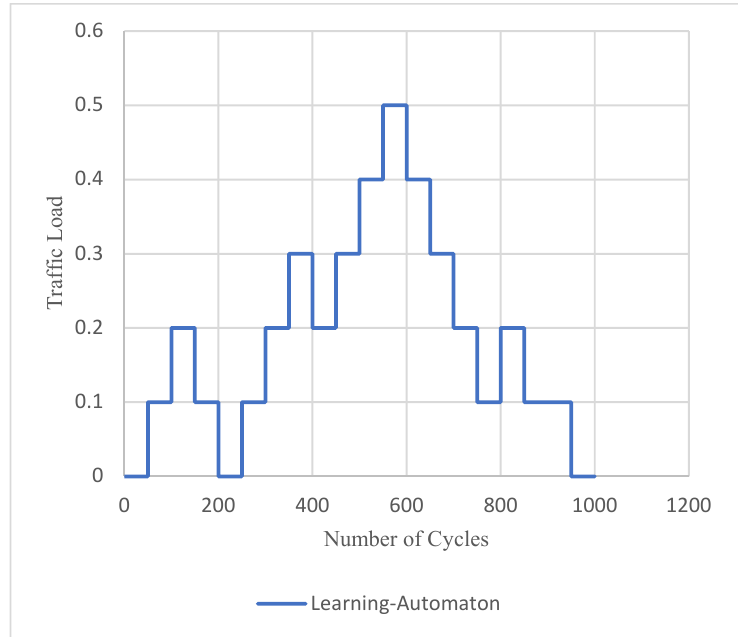
Figure 9. Event traffic load versus number of cycles.